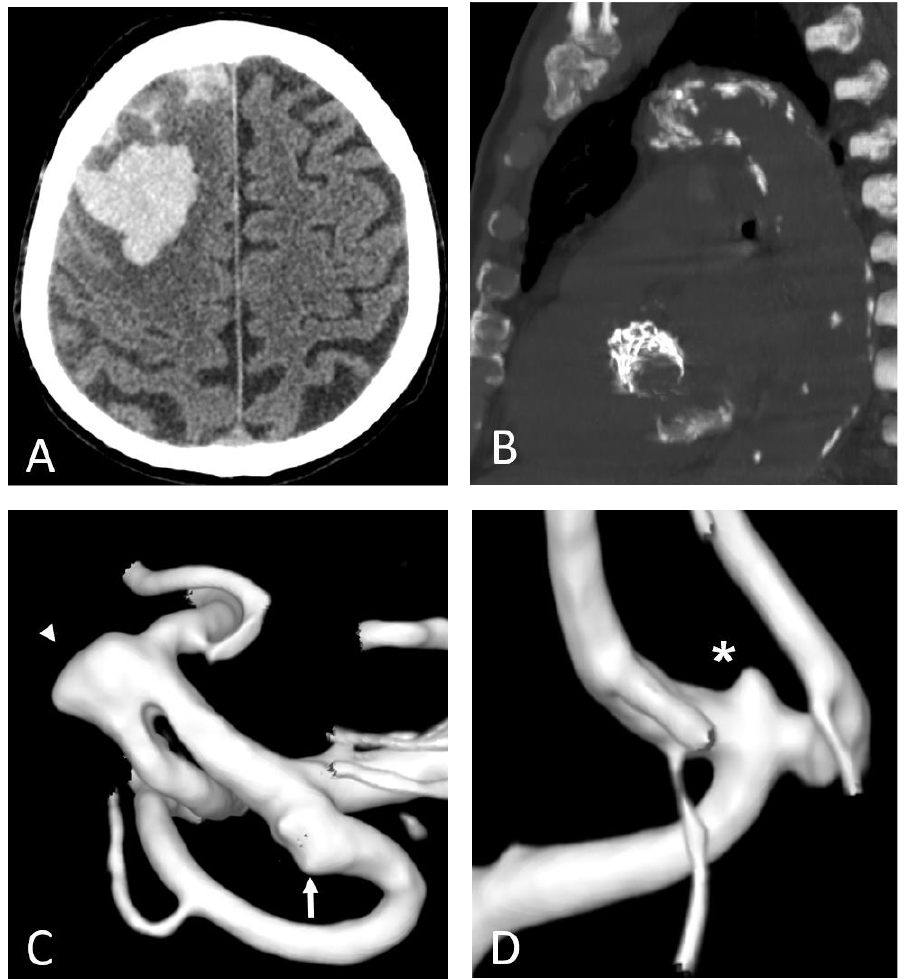
Figure 7. Polyvascular disease: right frontal lobar haemorrhage due to cerebral amyloid angiopathy ( A ) in an 82-year-old man with a prosthetic aortic valve and extensive calcifications of the aortic arch and along the descending thoracic aorta ( B ). Three-dimensional digital subtraction angiography reconstructions of the same patient ( C , D ) show diffuse arterial dysplasia with ecstatic origin of an inferior temporal branch (arrow), a dysmorphic aneurysm of the Sylvian bifurcation of the middle cerebral artery (arrowhead), and an infra-millimetric aneurysm of the anterior communicating artery (*).